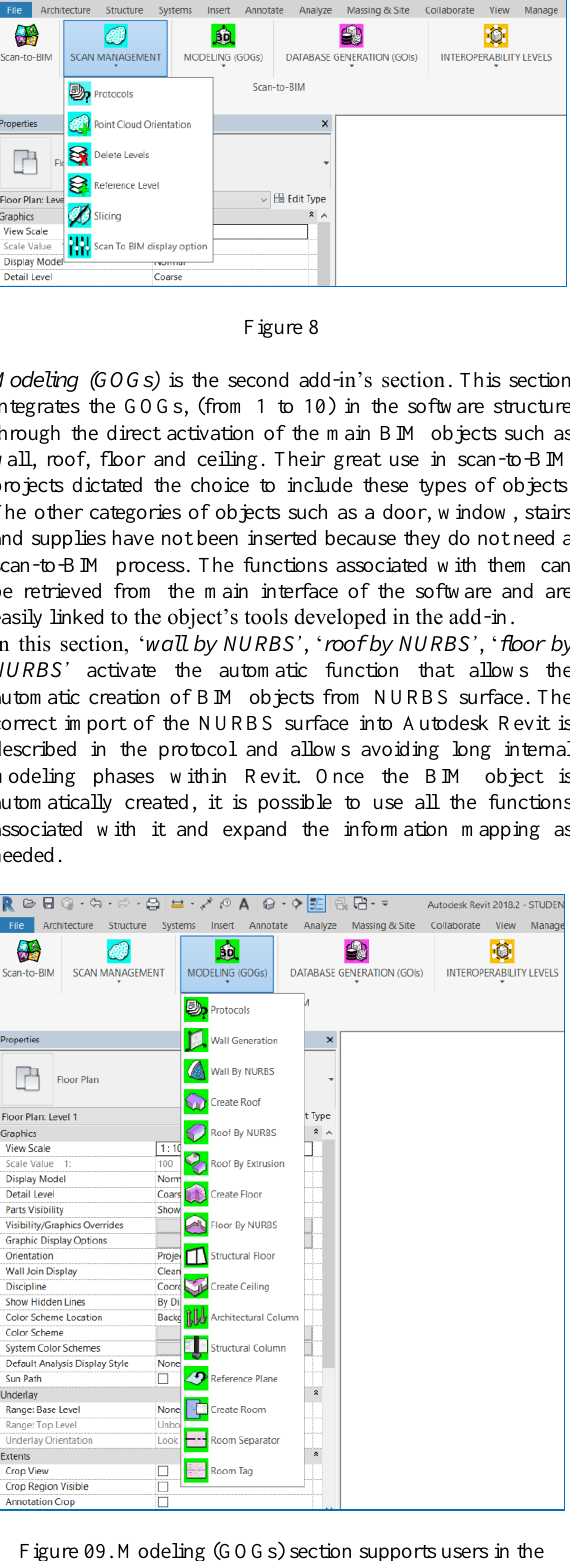
Figure 09. Modeling (GOGs) section supports users in the Figure 11. The fourth section of the developed add-in allows generative process of scan-to-BIM objects through implemented transferring the HBIM model in BIM cloud platform, VR functions and BIM protocols. software application, finite element analysis